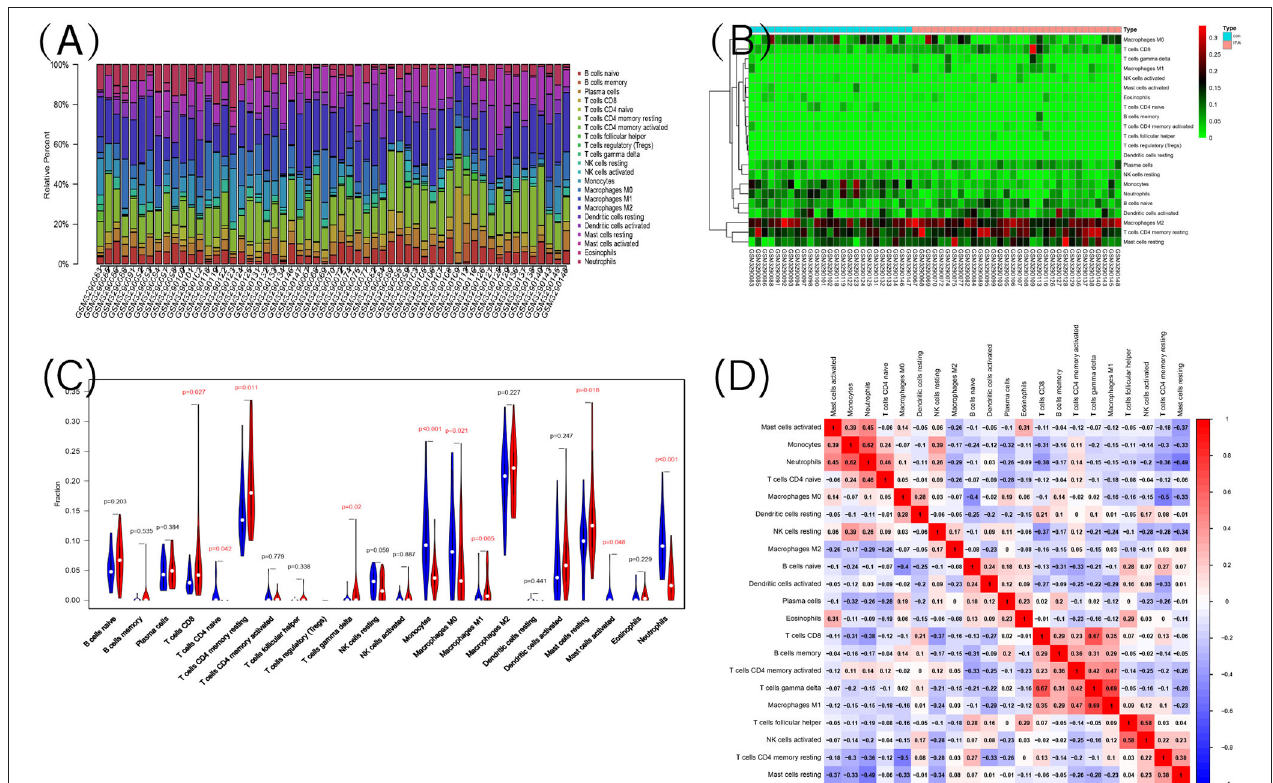
FIGURE 7 | The landscape of immune infiltration between IPAH and normal controls. (A) The relative percentage of 22 types of immune cells; (B) The heat map of 22 types of immune cells; (C) The difference of immune infiltration between IPAH and normal controls. The normal control group was marked as blue color and IPAH group was marked as red color. P- values < 0.05 were considered as statistically significant; (D) Correlation heatmap of the 22 types of immune cells. Blue presents a negative correlation, red represents a positive correlation, the darker the color, the stronger the